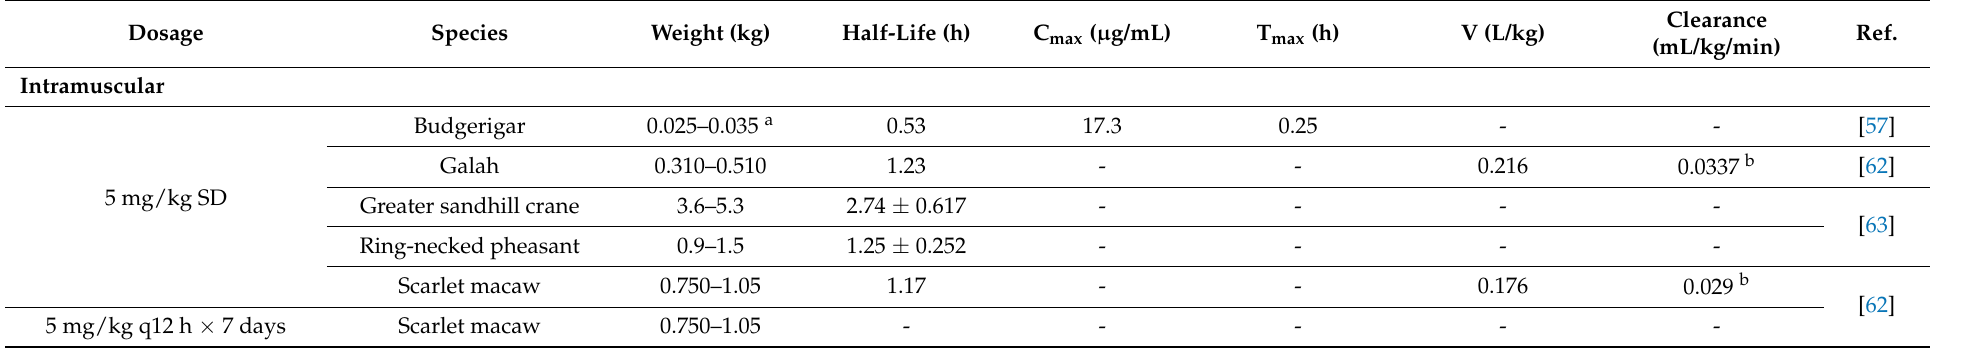
Table 7. Pharmacokinetic values of gentamicin in exotic avian